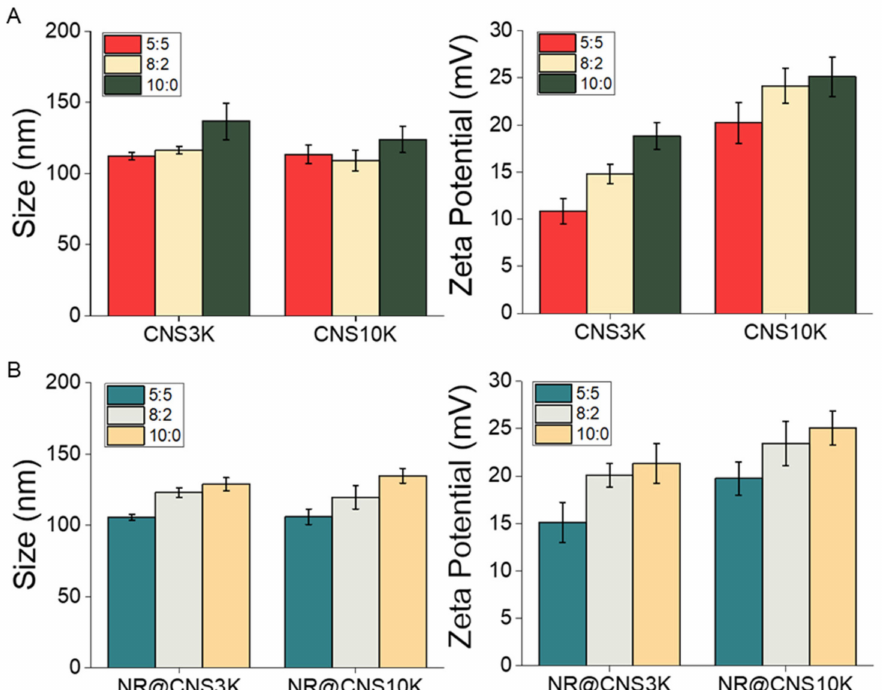
Figure 3. Hydrodynamic diameters and surface charges (zeta potentials) of the chitosan nanosponges ( A ) before and ( B ) after loading with Nile red (NR) at 37 ◦ C ( n = 3).